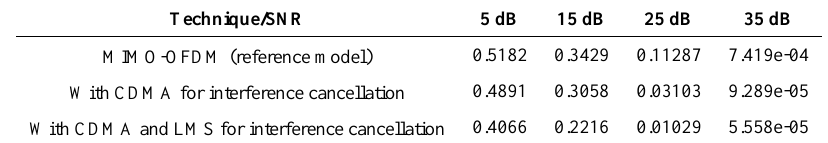
Table 2. BER Values corresponding to 5dB, 15dB, 25dB and 35 dB. SNR in Rician channel.